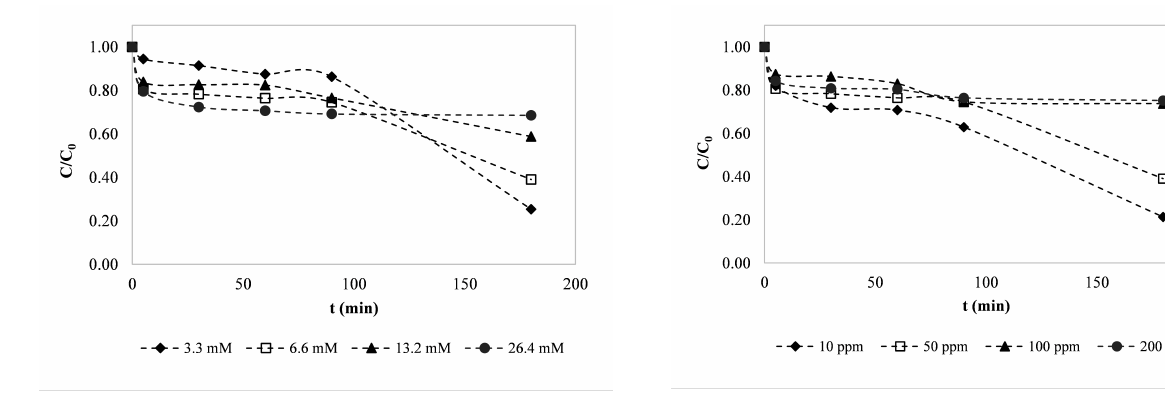
Fig. 4. Effect of H 2 O 2 dosage Fig. 5. Effect of Initial concentration of